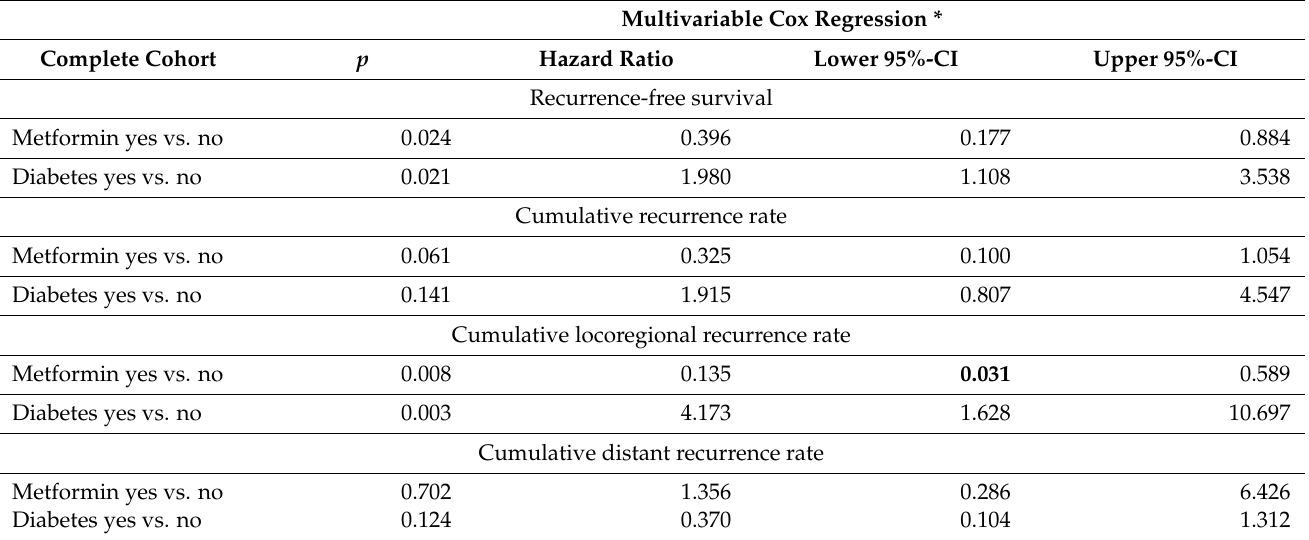
Table 4. Synopsis of the results from the multivariable Cox regression for RFS and cumulative re- currence rates according to metformin use in the diabetes complete cohort.